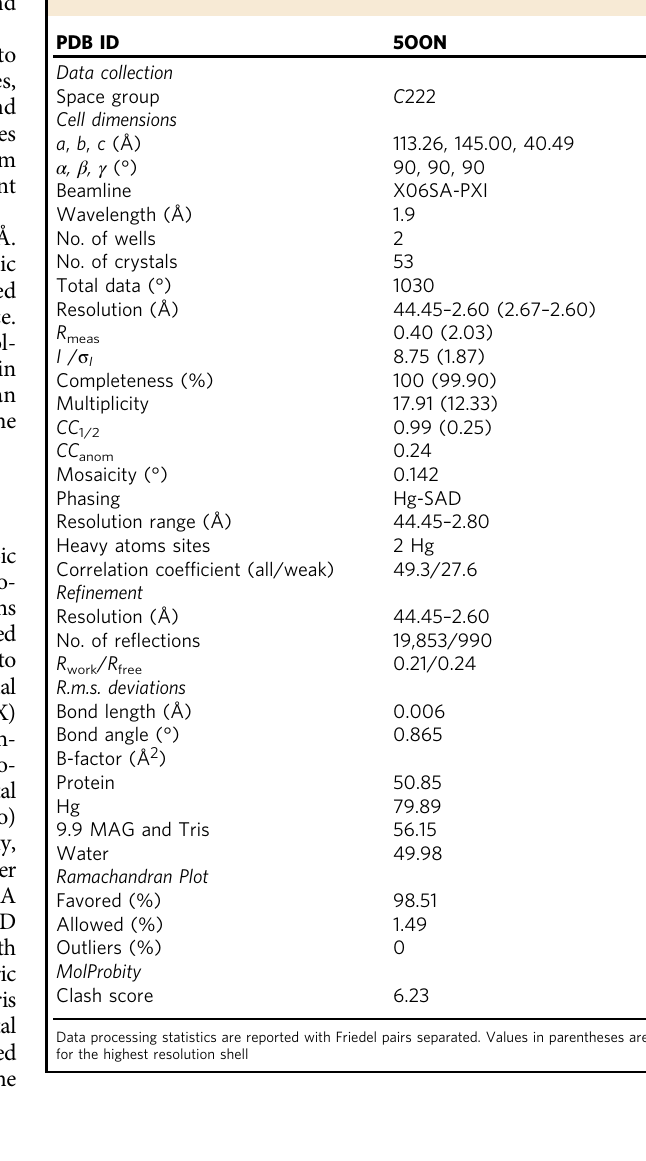
evolution constraints applied in the Rosetta structure prediction program to generate a structure of BacA 24 . The modeled protein includes a pair of inverted helices and has twofold pseudosymmetry as observed in the structure determined experimentally in the current study. The membrane orientation in d was not de fi ned. Putative catalytic residues Ser27 and R174 are indicated by red and blue dots, respectively